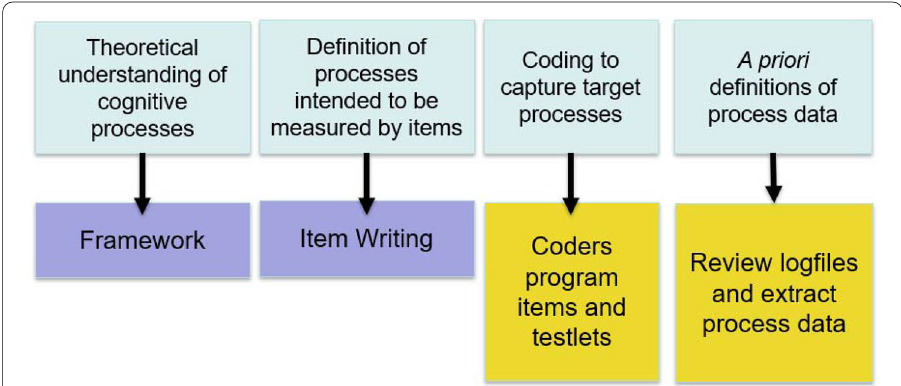
Fig. 6 Inputs shaping process data. Graphical representation of inputs that can shape and structure process data. Author’s own